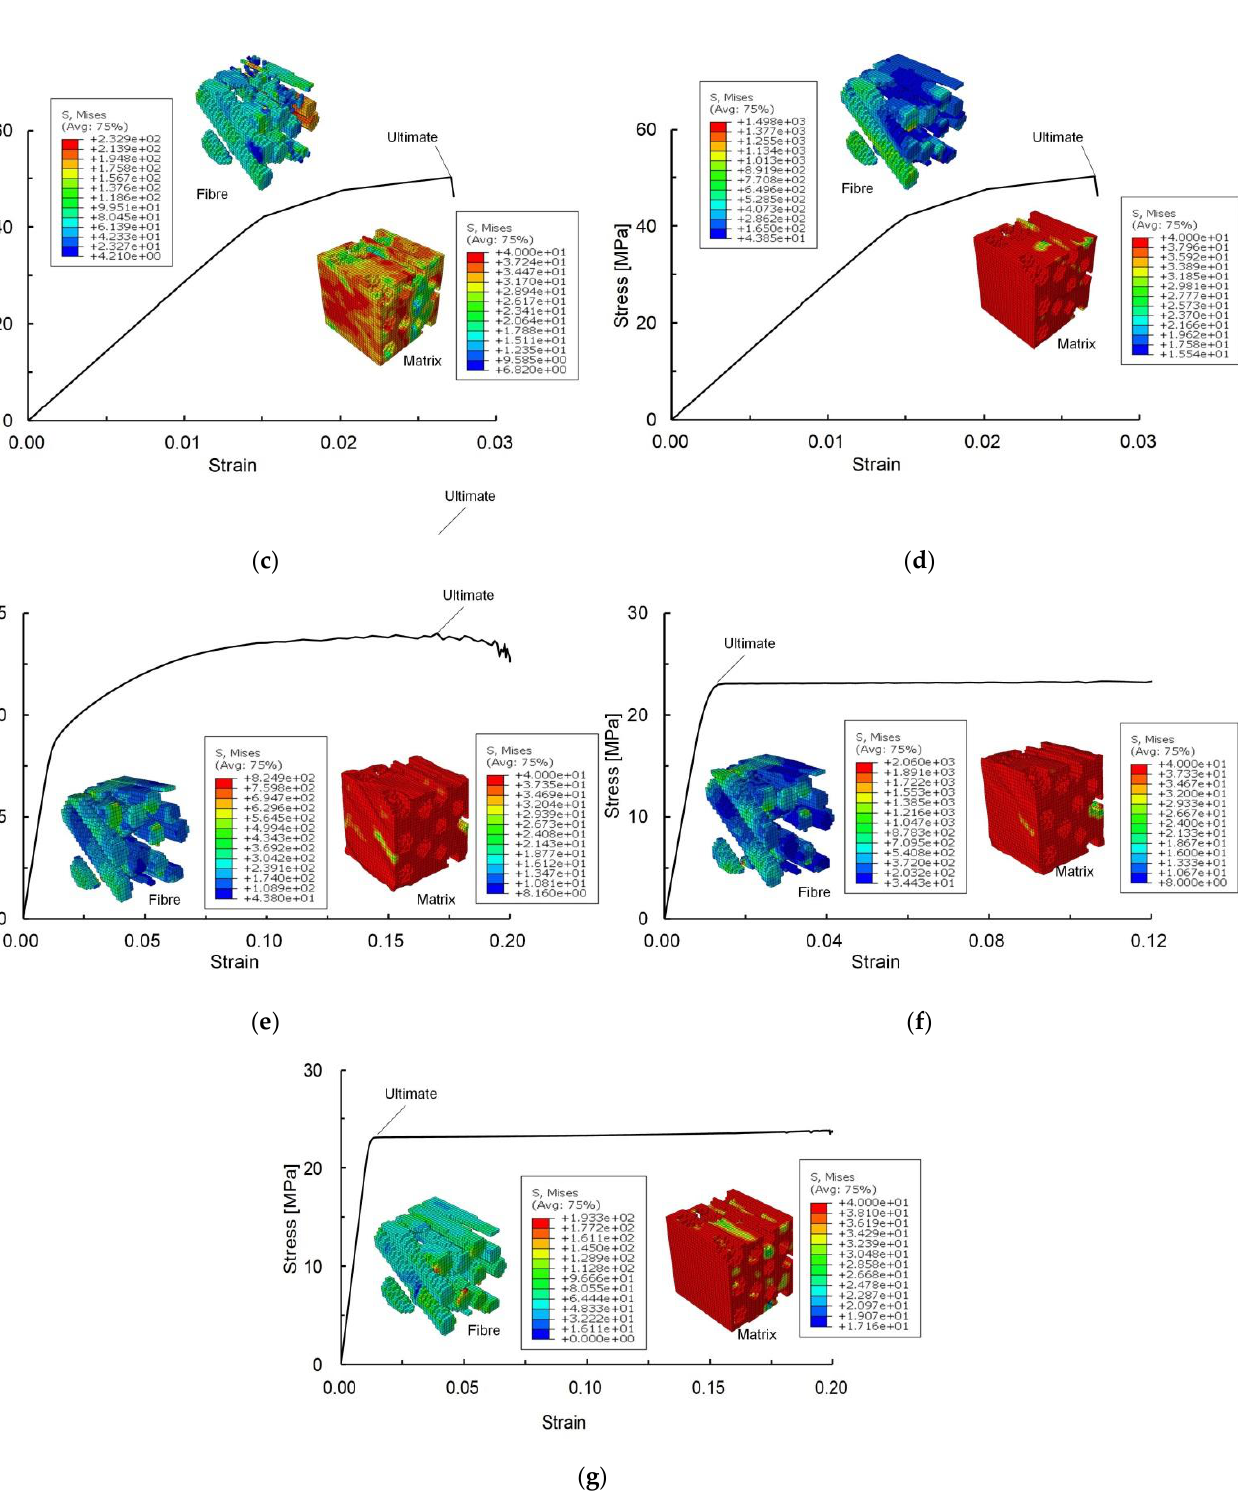
Figure 8. Equivalent stress-strain curves and von Mises stress plots of meso-scale RVE model of CSM laminate under ( a ) X-tension, ( b ) X-compression, ( c ) Y-tension, ( d ) Y-compression, ( e ) XY-shear, ( f ) XZ-shear, and ( g ) YZ-shear.